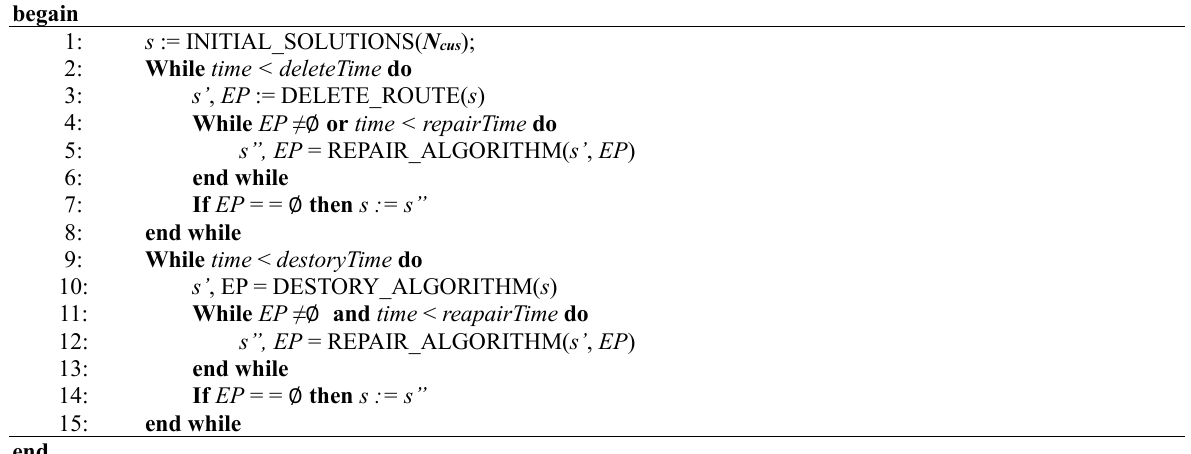
Algorithm 1 (Adaptive large neighborhood search)